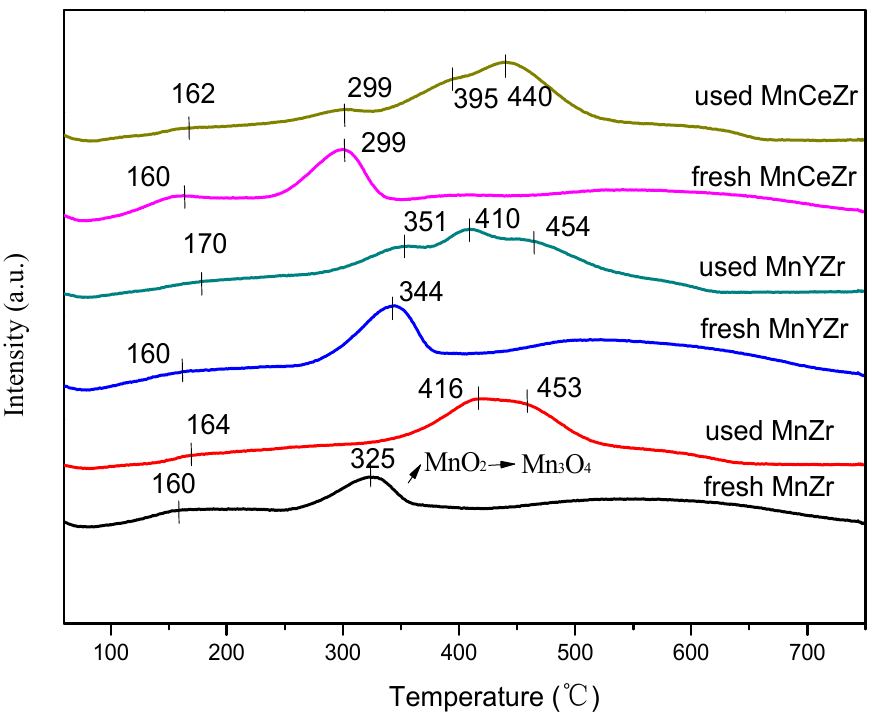
Figure 4. H 2 -TPR profiles of catalysts before and after the reaction in the presence of SO 2 .